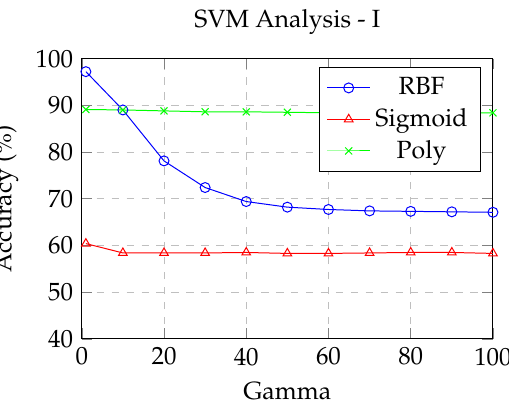
Figure 8. Analysis of SVM kernel accuracy for Unprotected implementation.